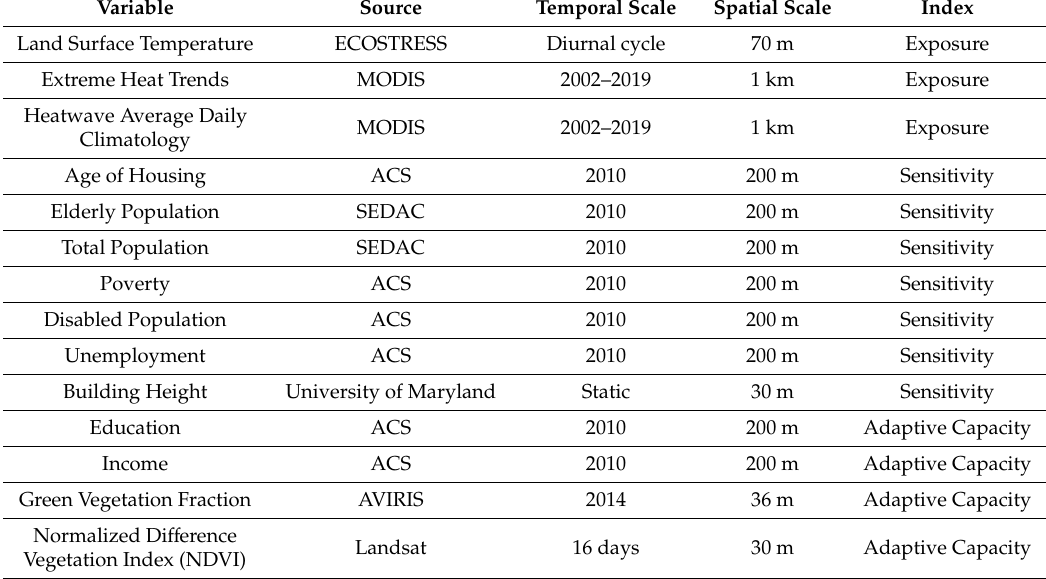
Table A1. Variables used as inputs to compute the HVI with information showing the source of data, time and spatial scales, and the assigned HVI index variable (exposure, sensitivity, adaptive